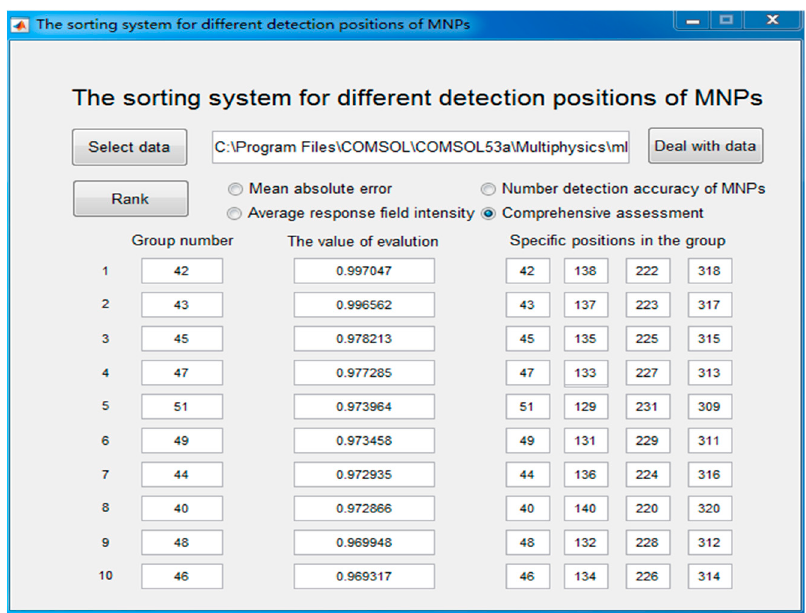
Figure 11. The sorting system for different detection positions of MNPs based on MATLAB GUI.